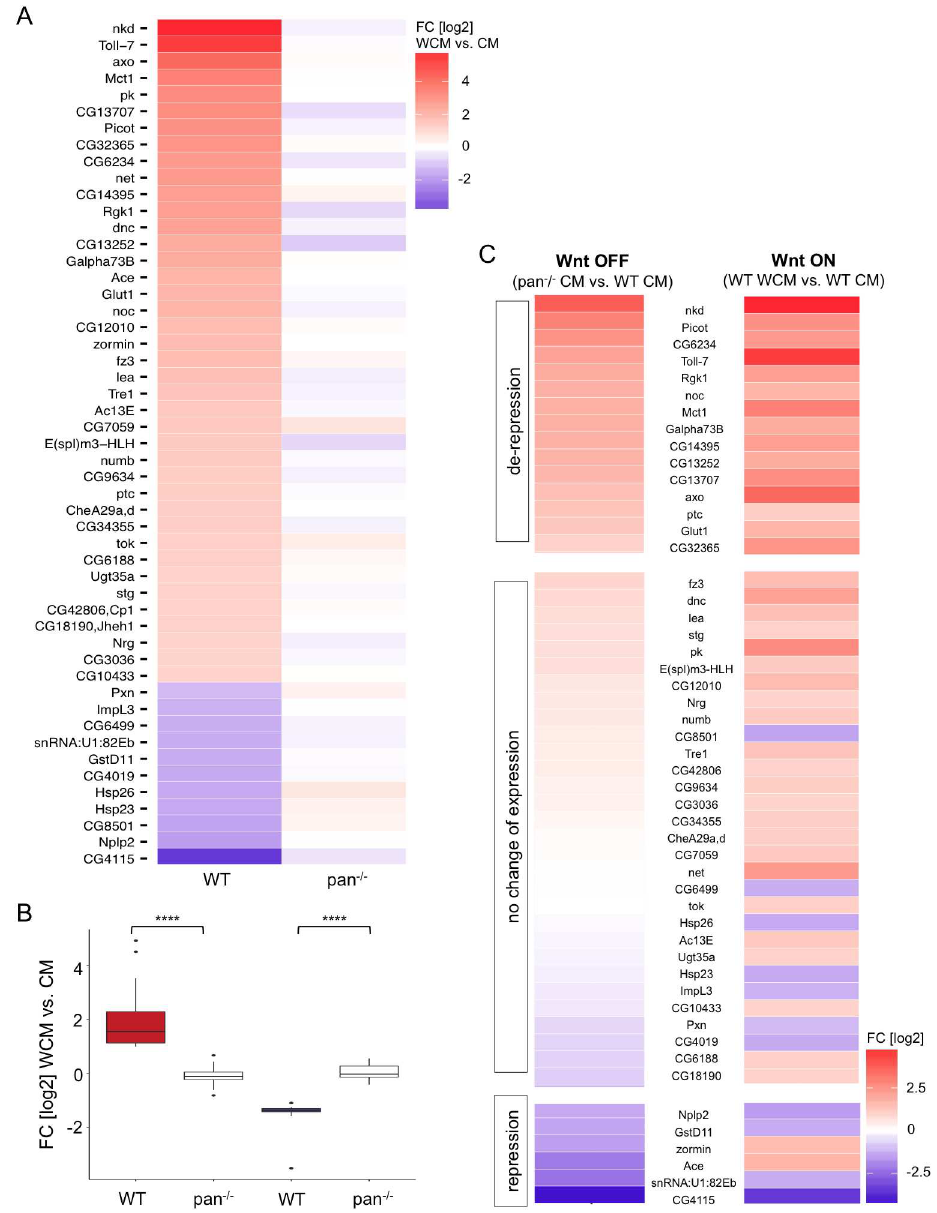
Fig 5. Gene expression analysis of Wnt/Wg target genes in pan -/–AF1AD26 cells. (A) Heat map of Wnt/Wg target genesshowingtheir log2 fold change(FC) of expressionafter WCM treatment versus control treatment in wild-type(WT) and pan -/–AF1AD26 (pan -/- ) cells, respectively. The genesare listed accordingto their intensity of inductionin WT cells. Strongest up-regulated genes are on top. Up-regulatedgenesare shown in red, down-regulatedgenes in blue, no expressionin white. (B) Boxplots showingthe difference in gene activity for up- and down-regulatedgenes after WCM stimulationin wild-type(WT) and pan -/–AF1AD26 (pan -/- ) cells. Paired t-test: *** (cid:20) 0.0001. (C) Gene expressionanalysisof Wnt/Wg target genes in the Wnt OFF and Wnt ON state. Heat map of log2 fold change (FC) accordingto the genotype(pan -/–AF1AD26 (pan -/- ) CM vs. wild-type (WT) CM) or WCM treatment (wild-typeWCM vs. wild-typeCM). The genes are listed accordingto their expressionlevels in the Wnt OFF state. Up-regulatedgenesare in red, down-regulated genesin blue, no expressionin white. De-repression: fold change(log2) (cid:21) 1, p-value (cid:20) 0.0005, repression: fold change(log2) (cid:20) -1, p-value (cid:20) 0.0005.